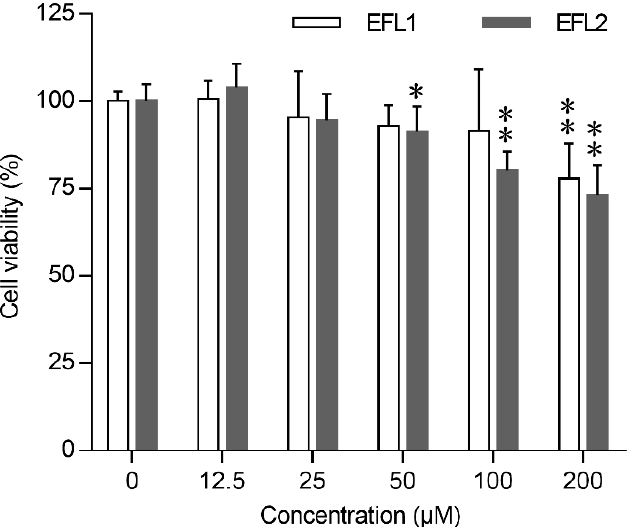
Figure 1. Cytotoxicity of EFLs in Caco-2 cells. Concentration effect of EFLs on cell viability was determined by the MTT assay, the cells viability of each EFLs group was expressed in percentage in comparison with vehicle control group. Data were presented as mean ± standard deviation from three independent experiments. * p < 0.05 or ** p < 0.01 compared with vehicle control of the same compound.